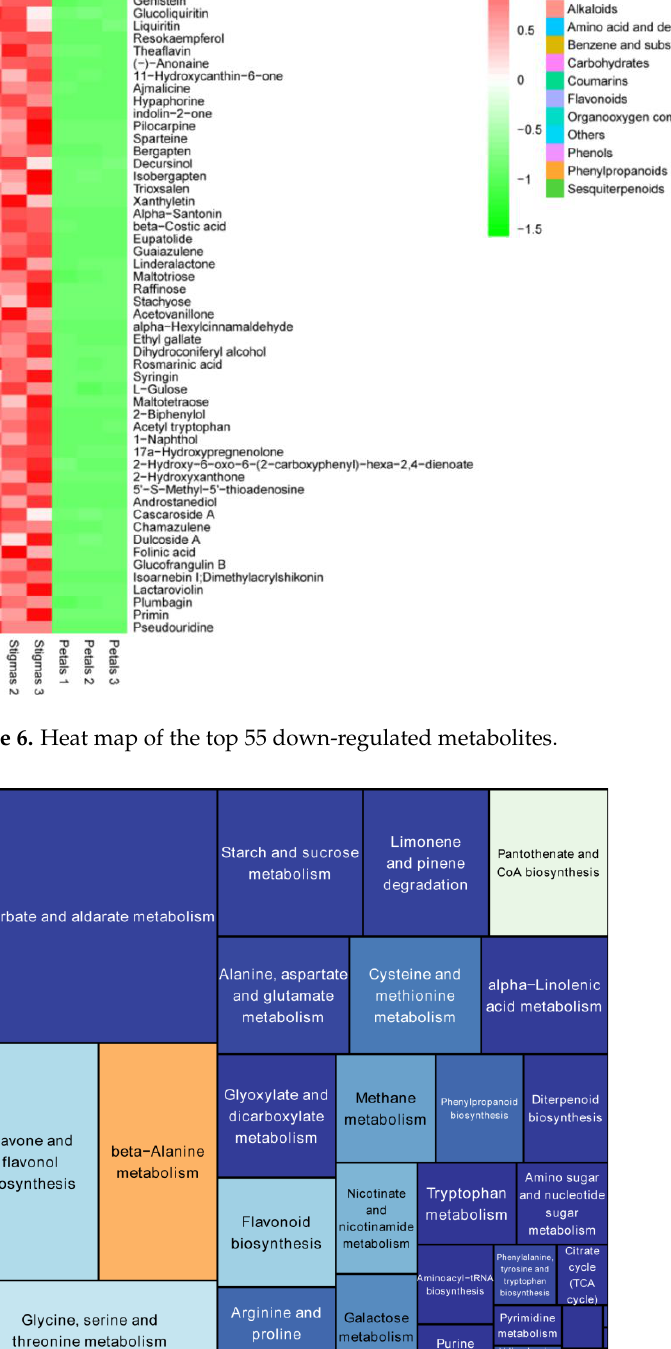
Figure 5. Heat map of the top 55 up-regulated metabolites. The abscissa in the figure represents different experimental samples, and the ordinate represents the differential metabolites compared in the group. Red or green in heatmap indicates high or low expression, respectively, according to the color bar in logarithmic scale shown above the heatmap. The same setup applies to the following Figure 6.